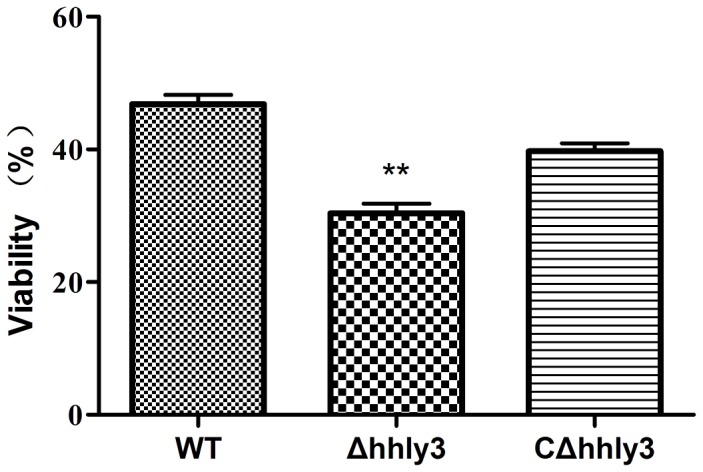
Survival of the WT, Δhhly3, and CΔhhly3 strains in pig whole blood.The percentage survival rate of Δhhly3 was significantly lower than that in the WT strain and the complement strain CΔhhly3 (** P < 0.01).